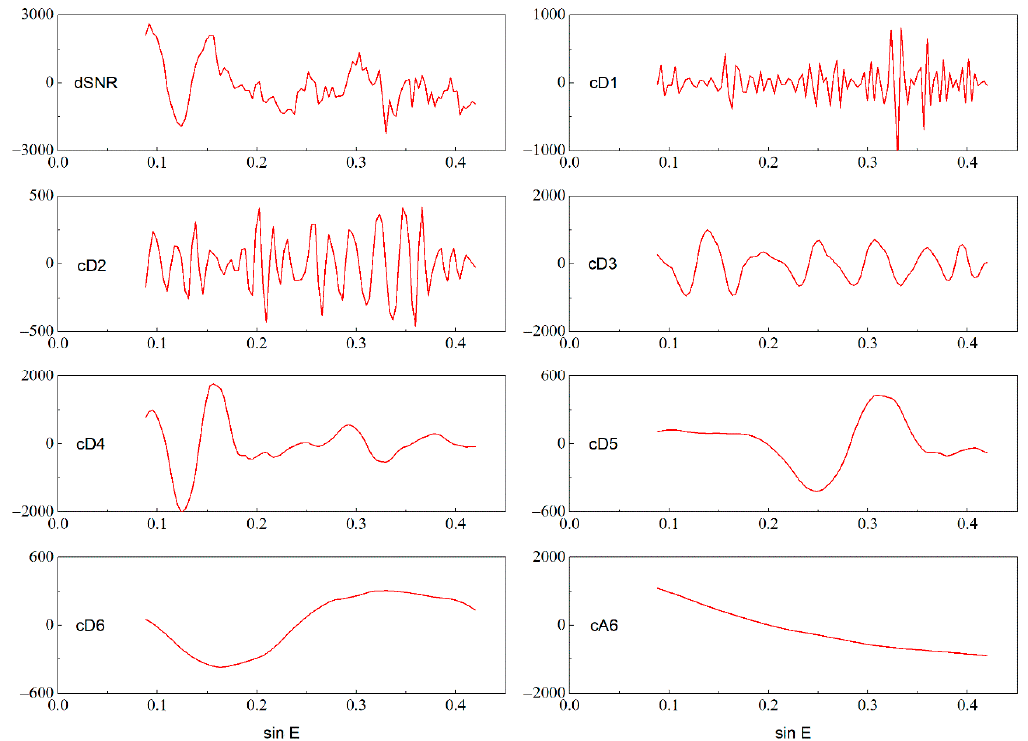
Figure 3. Wavelet decomposition results for the dSNR sequence for GPS PRN 19 on February 28, 2018.